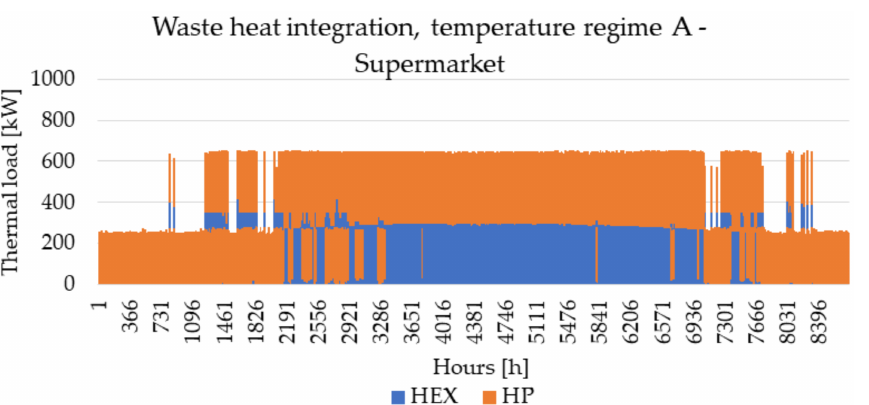
Figure A1. Waste heat temperature regimes—supermarket.